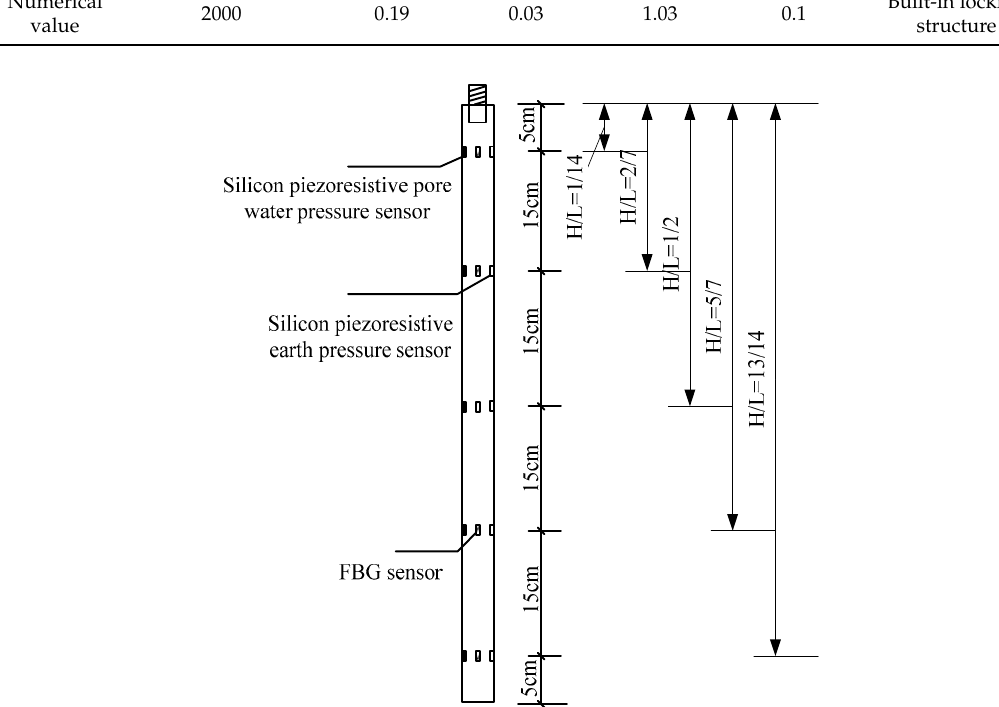
Figure 9. Distribution diagram of sensor arrangement.